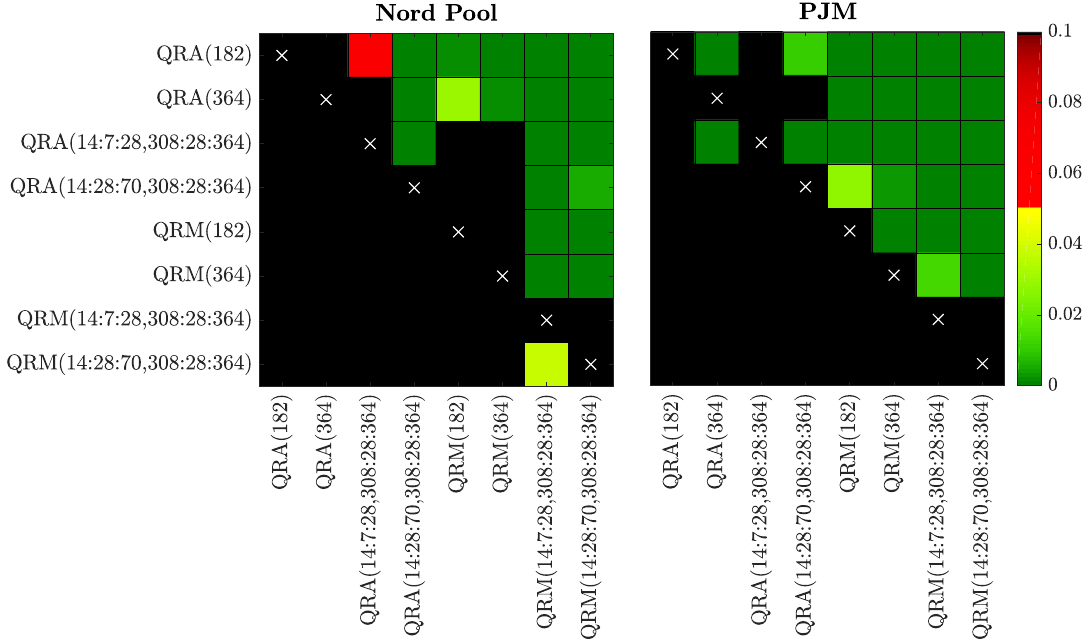
Figure 7. Results of the conditional predictive ability (CPA) test [19] for forecasts of selected models for the Nord Pool ( left ) and PJM ( right ) data. We use a heat map to indicate the range of the p -values—the closer they are to zero ( → dark green) the more significant is the difference between the forecasts of a model on the X -axis (better) and the forecasts of a model on the Y -axis